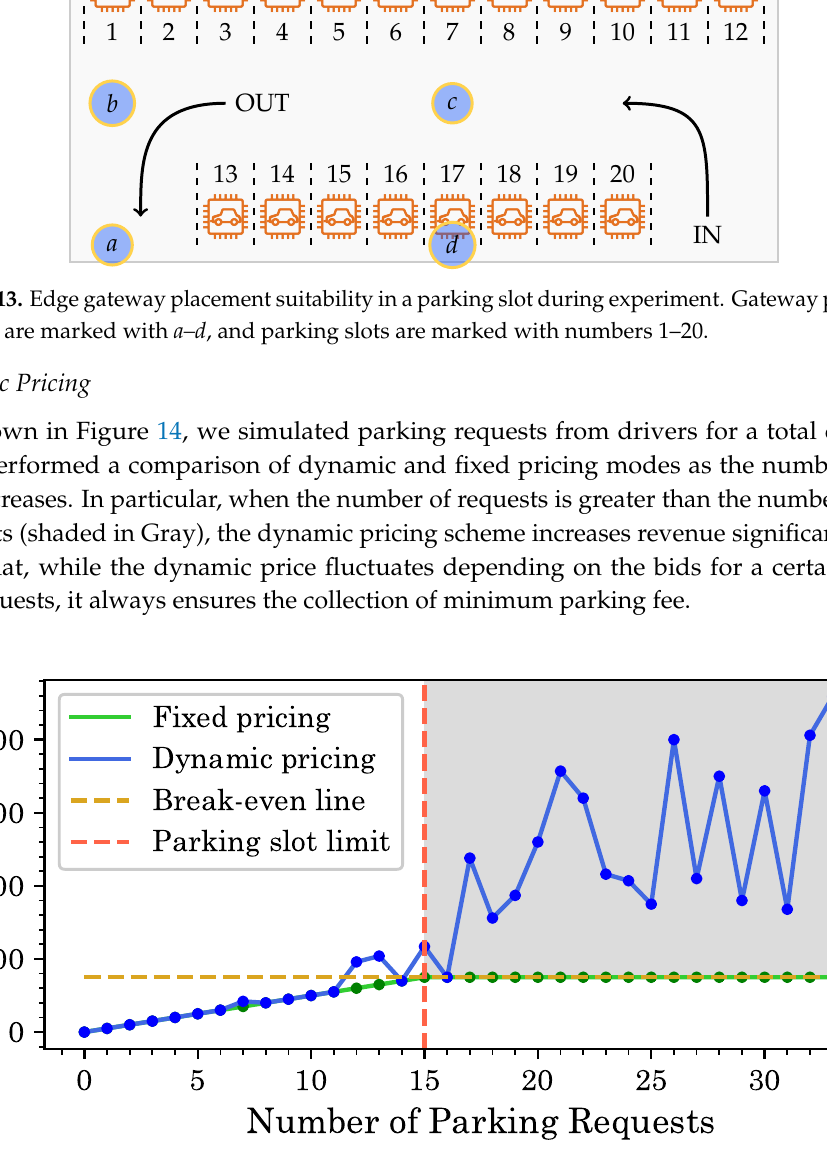
Figure 14. Comparison of fixed and dynamic parking fee